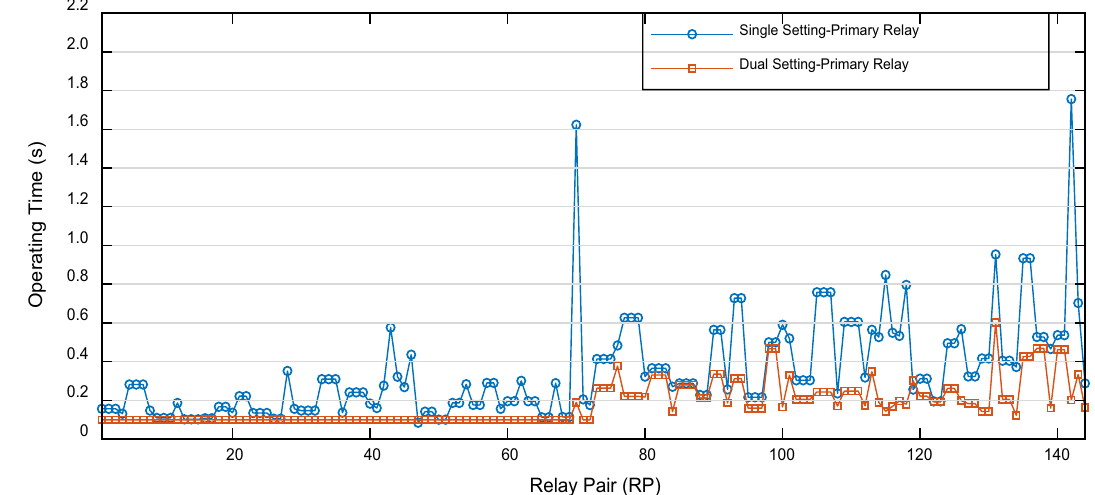
Fig.12 Primary relay operating time using single and dual setting overcurrent relays for common relay setting in 18 bus microgrid test system